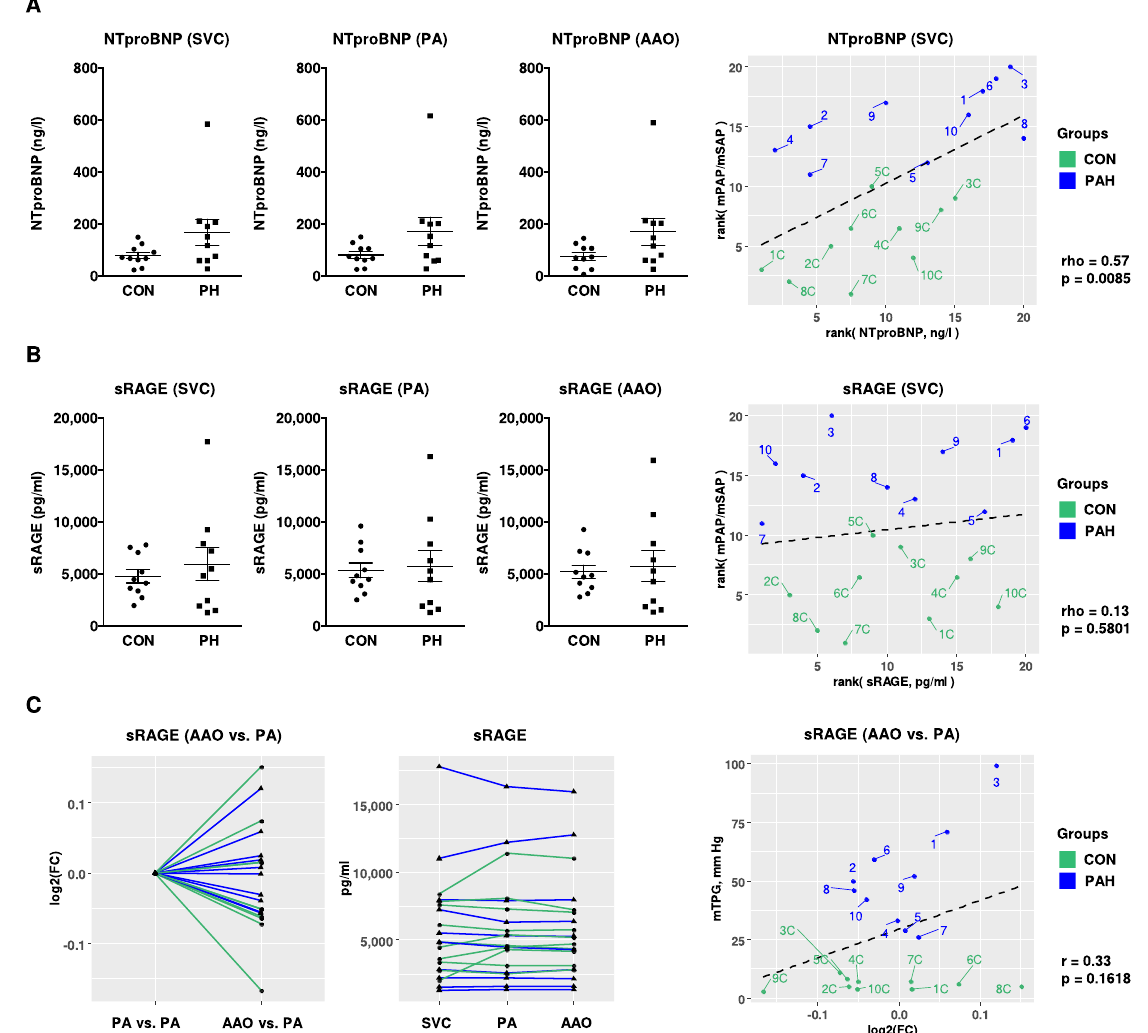
Figure 5. Compartment-specific blood plasma concentrations of NTproBNP and sRAGE in children with PH vs. non-PH controls in the systemic and pulmonary circulation. ( A , B ) NTproBNP and sRAGE plasma concentrations in the SVC, PA and AAO of pediatric patients with pulmonary hypertension (PH; n = 10) versus non-PH controls (CON; n = 10) and correlations with mPAP/mSAP. For measurement of sRAGE, samples were diluted 1:4, followed by enzyme-linked immunoassay (ELISA). ( C ) There were no different levels of sRAGE across the pulmonary circulation (AAO vs. PA) and the transpulmonary log2 fold changes of sRAGE do not correlate with mTPG. Data are shown as mean ± SEM. Statistical test: